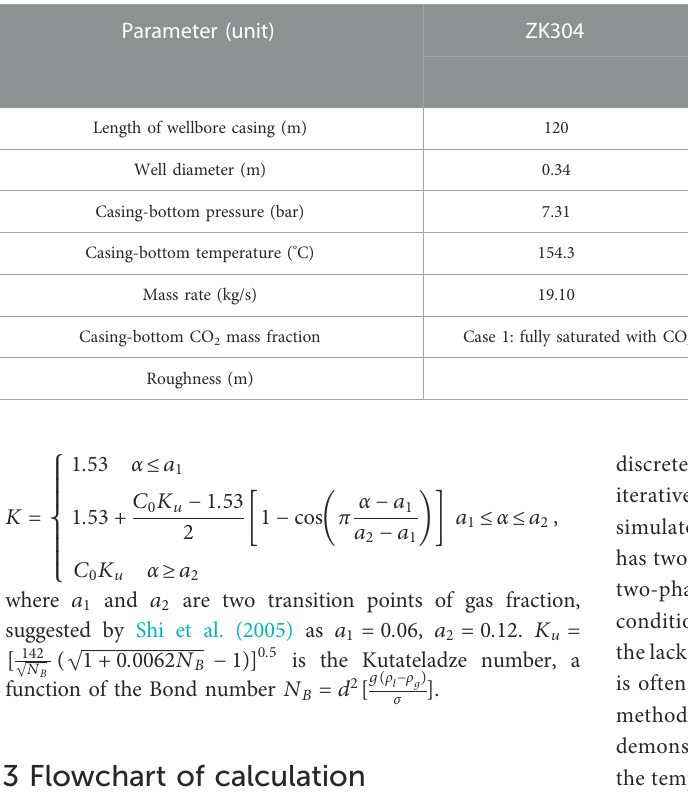
TABLE 2 Parameters for fl ow